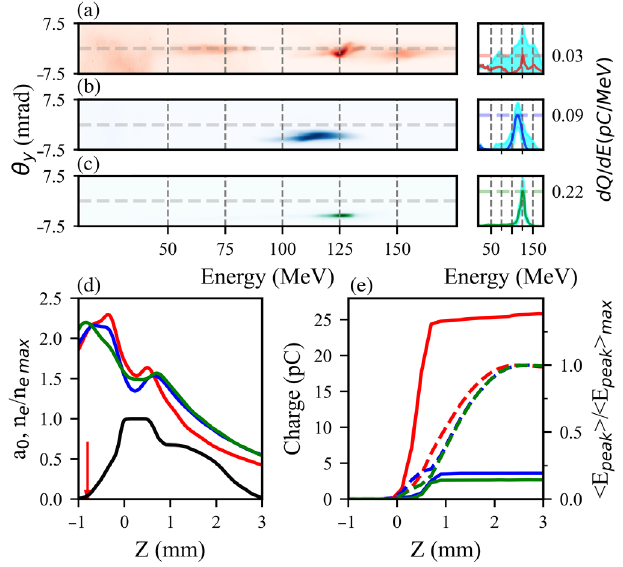
FIG. 9. Experimental spectra (a) – (c) illustrating the effect of phase front optimization on accelerated electron bunches at laser ¼ − 0 . 8 mm for wavefront configurations (a) FPS, focus z foc (b) 1bFPS, and (c) 2bFPS. Electron charge density in divergence- energy space (pC MeV − 1 m rad − 1 ) and their corresponding spatially integrated dQ=dE (pC MeV − 1 ) within a (cid:2) 7 . 5 m rad window around the laser axis indicated by the dashed horizontal line and in an energy window of 11.3 and 175 MeV. Standard deviation calculated over five shots and plotted here in cyan. (d) simulation results for the evolution along the propagation distance z of the normalized vector potential a 0 of the laser pulse: the black curve represents the normalized plasma density profile, while the focus position, z , is marked by the red arrow; foc (e) evolution with z of the charge of the electrons having final energy above 10 MeV (solid lines) and the average energy of the electrons contributing to the peak in energy normalized by its maximum values (dashed lines). For (d) and (e), the red curves correspond to FPS, blue curves to 1bFPS, and green to